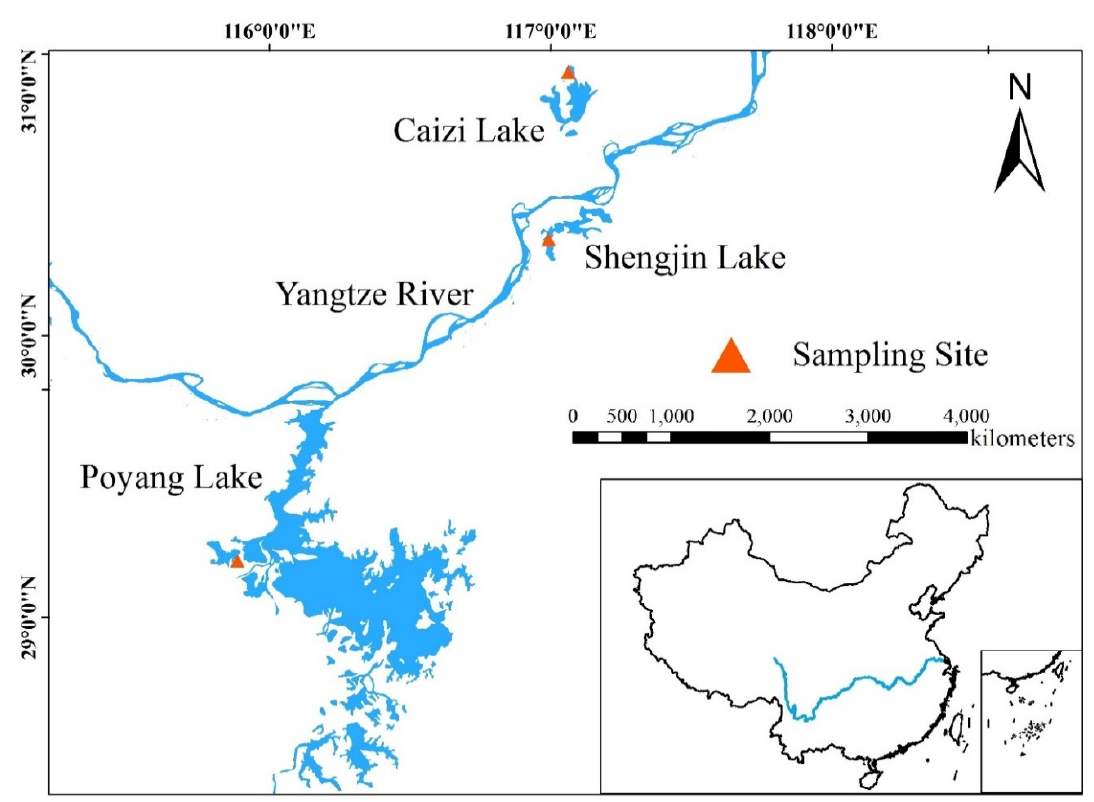
Figure 1. Fecal sampling sites of Hooded Cranes at Poyang, Caizi, and Shengjin Lakes.